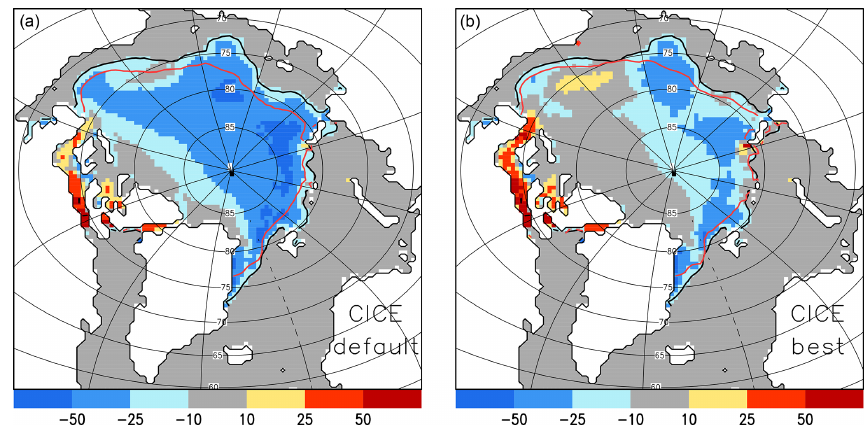
Figure 4. Difference in mean September sea ice concentration (2005–2014) in % between the CICE simulation and SSM/I Bootstrap data. Negative values mean lower ice concentration in CICE. The black line indicates mean SSM/I and the red line the mean CICE sea ice extent: (a) CICE-default and (b) CICE-best.